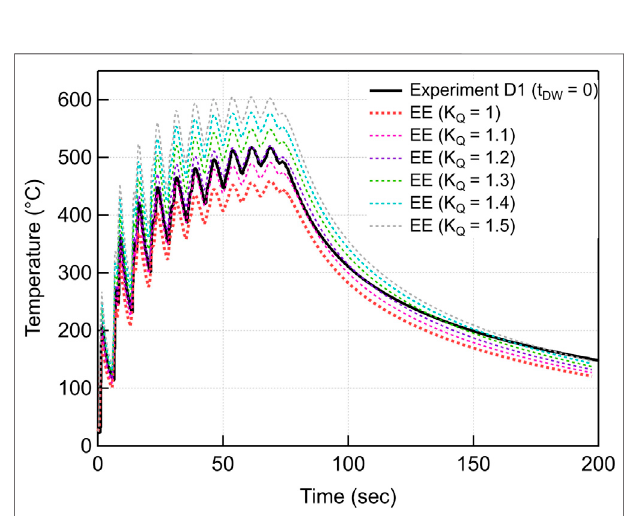
FIGURE 13 | Effect of source correction factor (K Q ) on temperature evolution at thermocouple location for K E (cid:2) 4 (sub-track size) for experiment case D1.